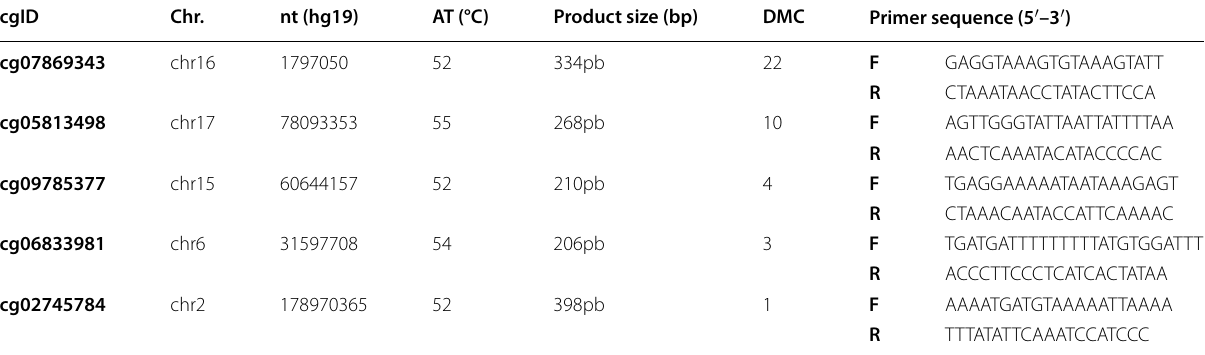
Chr . Chromosome, At Annealing temperature, bp Base pair, F Forward, R Reverse